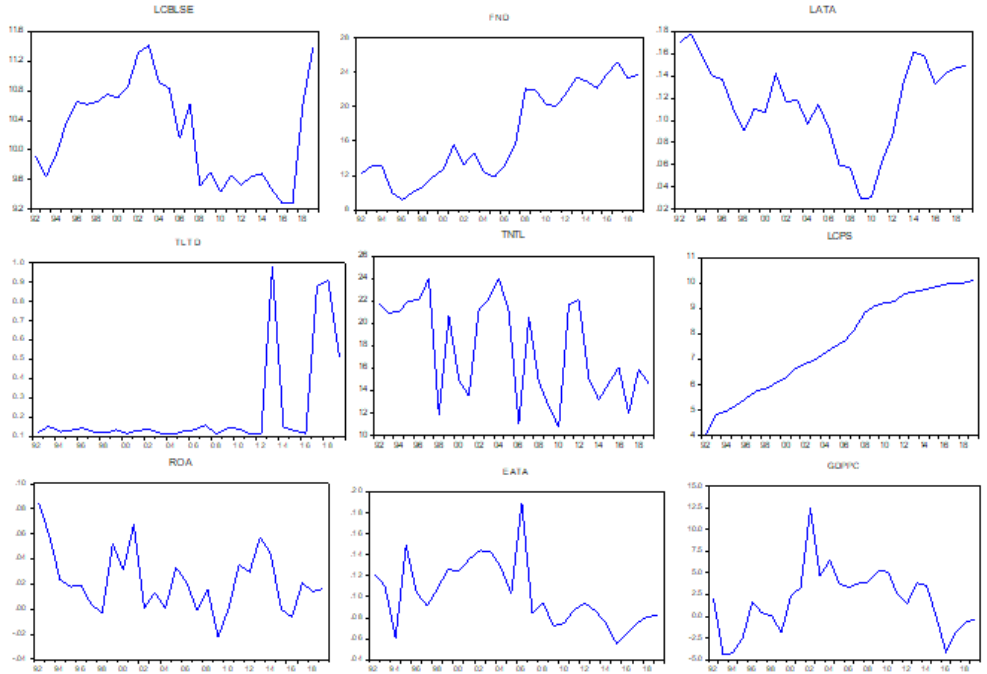
Figure 2. Trend of banking stability and